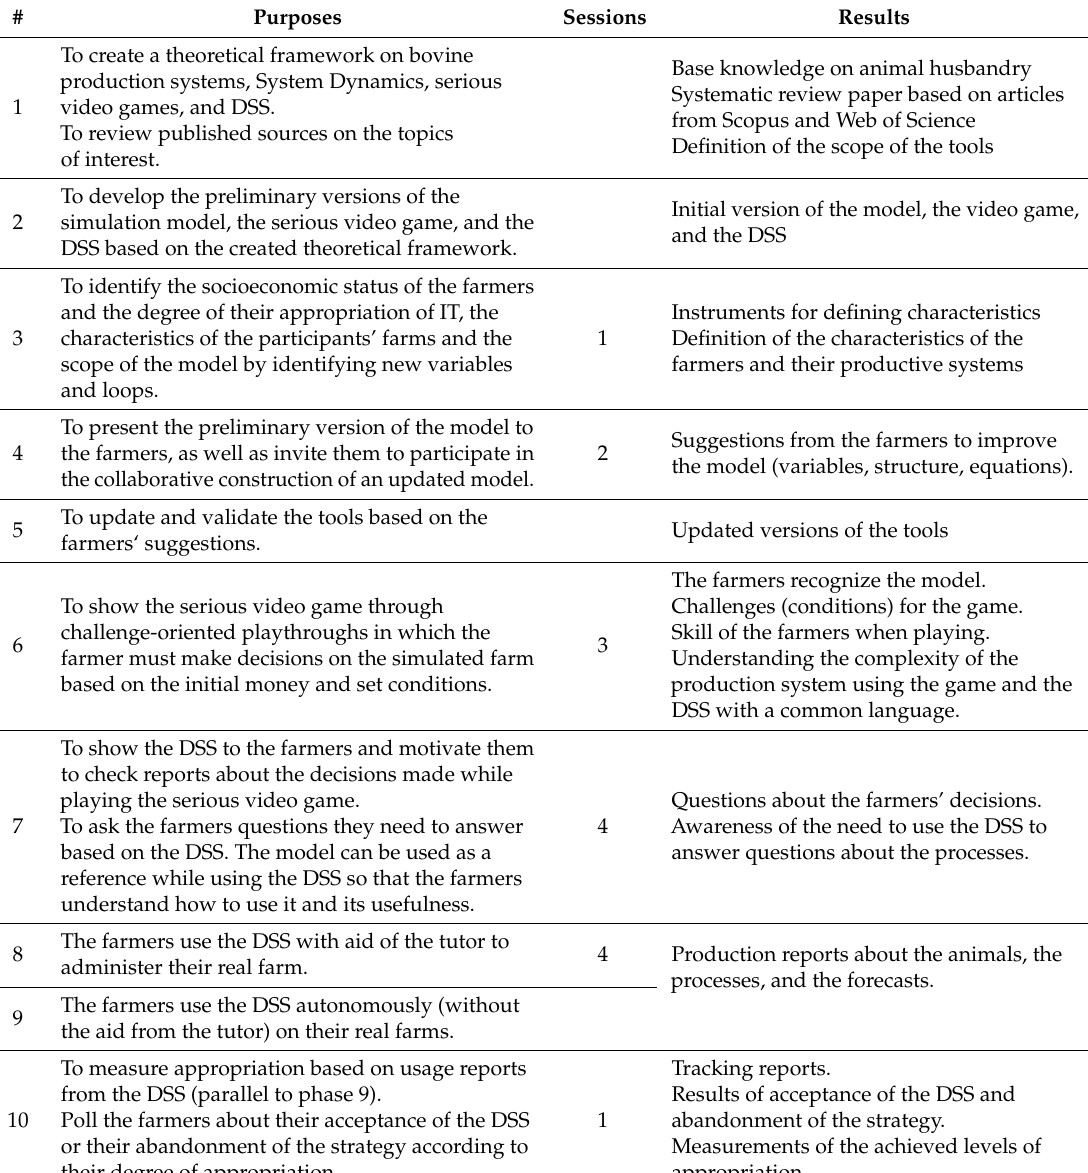
Figure 6. Scheme of the strategy. Table 3. Description of the phases of the proposed strategy